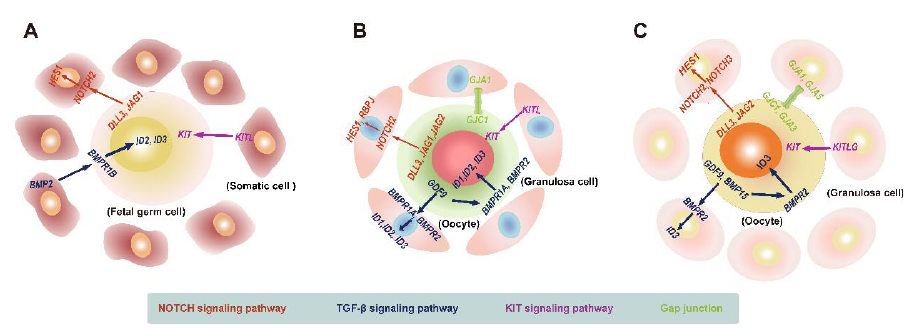
Figure 3. Canonical intercellular interactions in the ovary. ( A ) Schematic diagram showing the interaction of female human fetal germ cells and gonadal somatic cells mediated by typical signaling pathways. For the NOTCH signaling pathway, DLL3 and JAG1 is expressed on fetal germ cells, and the NOTCH receptor ( NOTCH2 ) as well as targets ( HES1 ) are expressed on somatic cells; for the TGF- β signaling pathway, BMP2 is expressed on somatic cells, and its receptor ( BMPR1B ) and target genes are expressed on fetal germ cells; for the KIT signaling pathway, the ligand KITL is expressed on somatic cells, while the KIT receptor is expressed on fetal germ cells. ( B ) Schematic illustration displaying the bidirectional communication between oocytes and granulosa cells during the primordial follicular assembly. For the NOTCH signaling pathway, the ligands DLL3, JAG1 , and JAG2 are expressed on oocytes, and NOTCH receptors ( NOTCH2 ) as well as targets ( HES1 and RBPJ ) are expressed on granulosa cells; for the TGF- β signaling pathway, GDF9 is expressed on oocytes, while its receptors ( BMPR1A and BMPR2 ) and targets ( ID1, ID2 , and ID3 ) are expressed on oocytes and granulosa cells; for the KIT signaling pathway, the ligand KITL is expressed on granulosa cells, while the receptor KIT is expressed on oocytes; for gap junctions, GJA1 is expressed on granulosa cells, and GJC1 is expressed on oocytes. ( C ) Schematic diagram showing the characteristics of the intercellular crosstalk between oocytes and granulosa cells throughout folliculogenesis. For the NOTCH signaling pathway, the ligands DLL3 and JAG2 are expressed on oocytes, and NOTCH receptors ( NOTCH2 and NOTCH3 ) as well as targets ( HES1 ) are expressed on granulosa cells; for the TGF- β signaling pathway, GDF9 and BMP15 are expressed on oocytes, and its receptor ( BMPR2 ) and targets ( ID3 ) are expressed on oocytes and granulosa cells; for the KIT signaling pathway, the KITLG ligand is expressed on granulosa cells, while the KIT receptor is expressed on oocytes; for gap junctions, GJA1 and GJA5 are expressed on granulosa cells, and GJC1 and GJA3 are expressed on